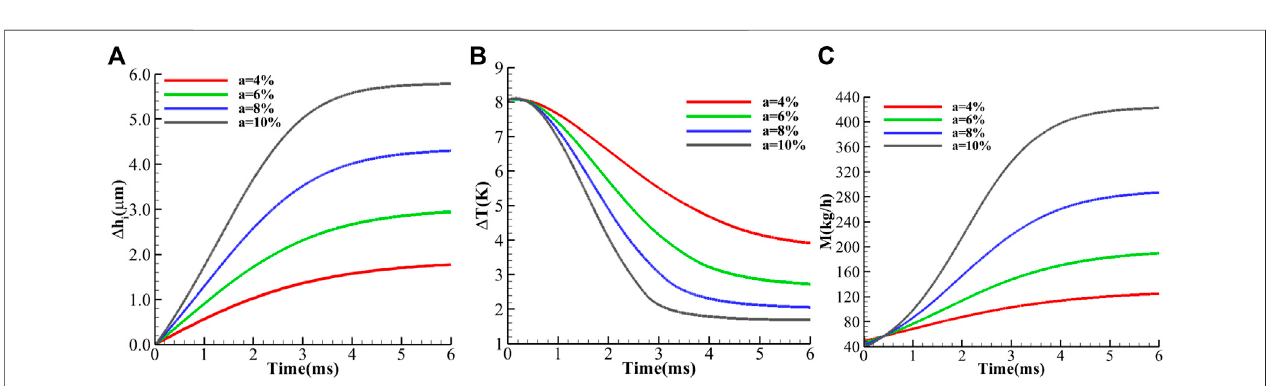
FIGURE 16 | Variation of parameters with time (A) static ring displacement, (B) inlet-to-outlet temperature difference, and (C) the leakage.